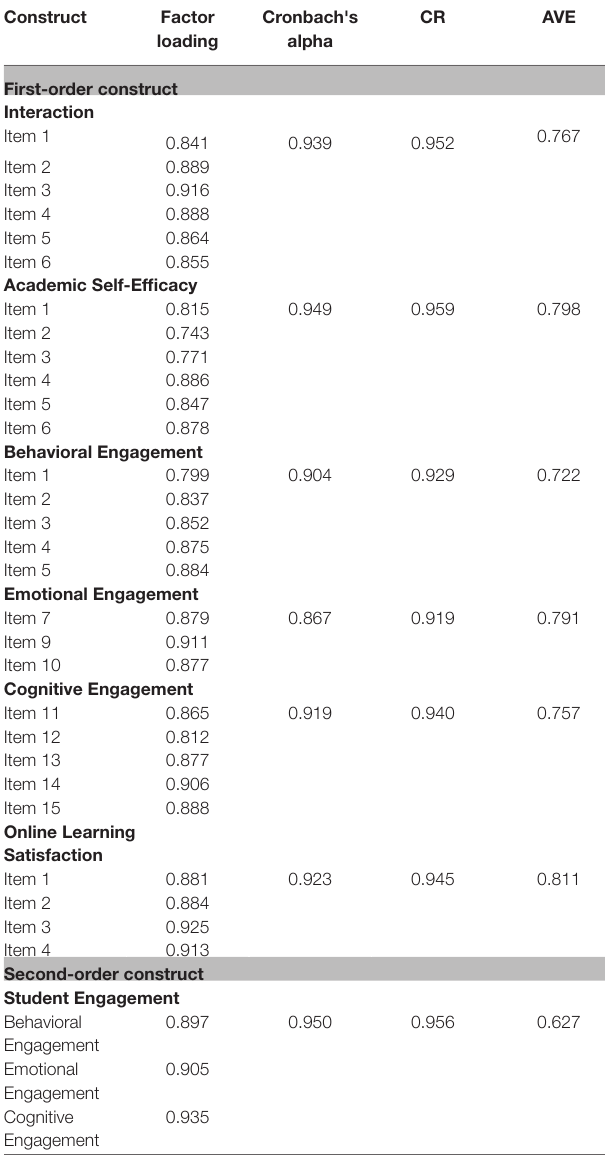
TABLE 1 | Results of the measurement model